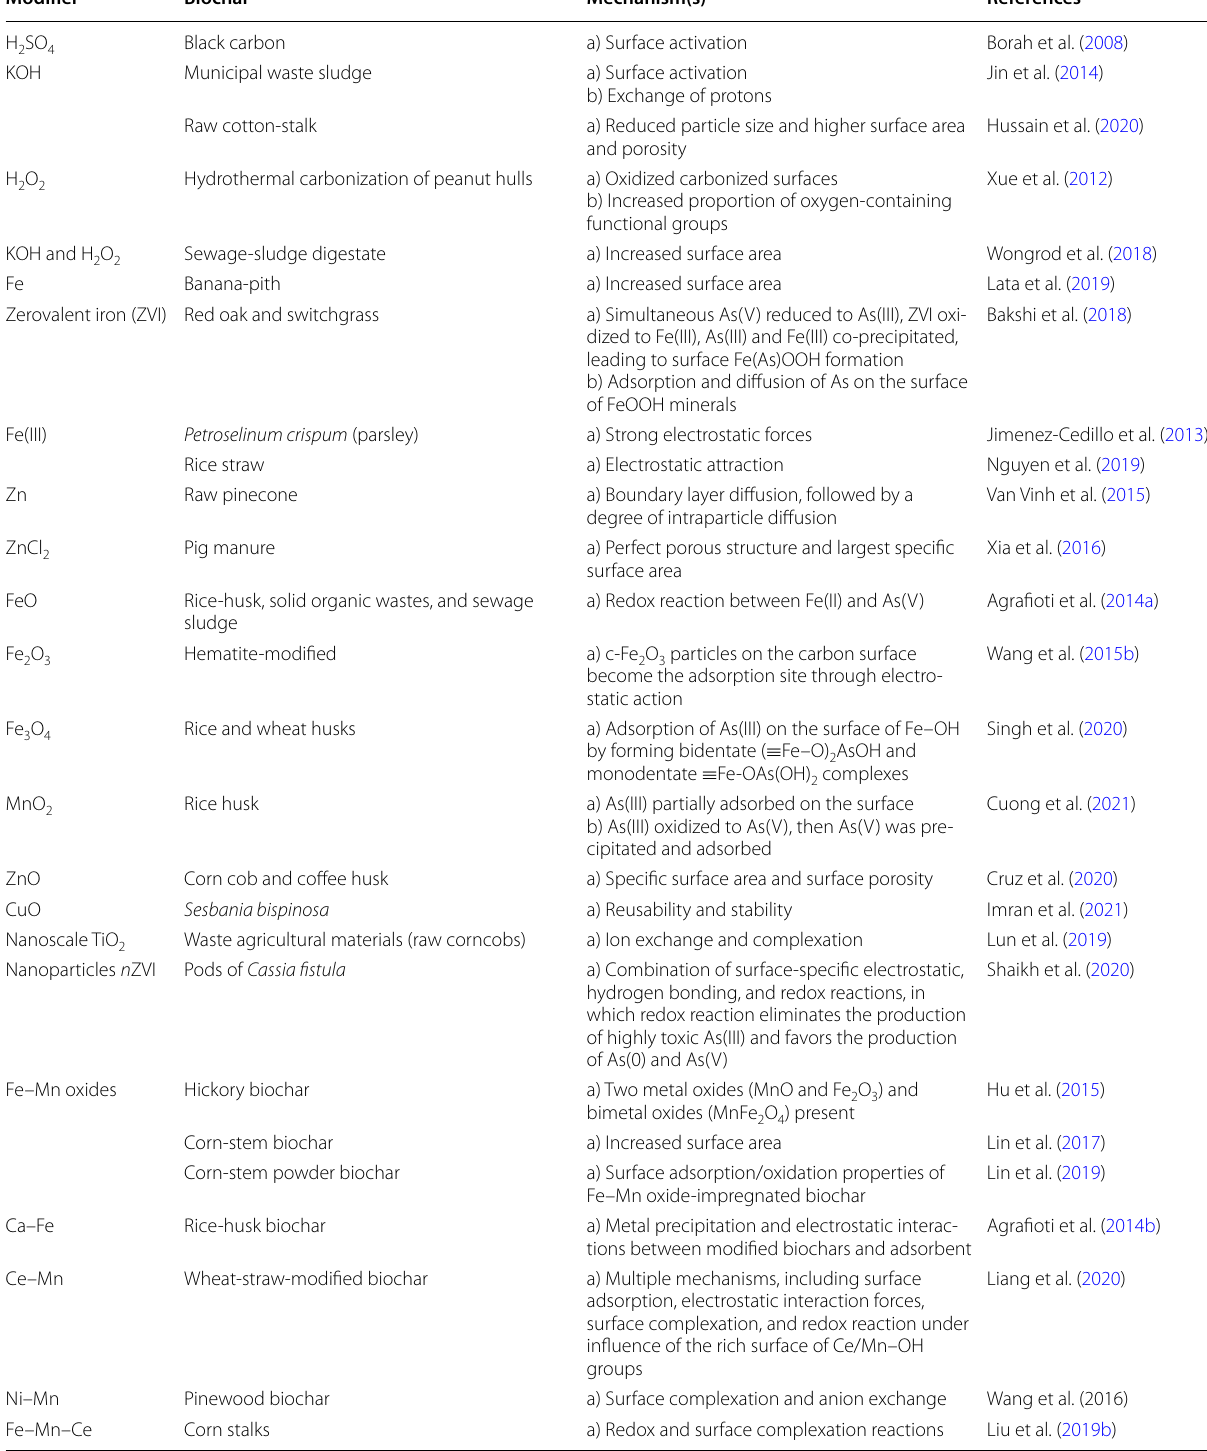
Table 3 Biochar modifiers and